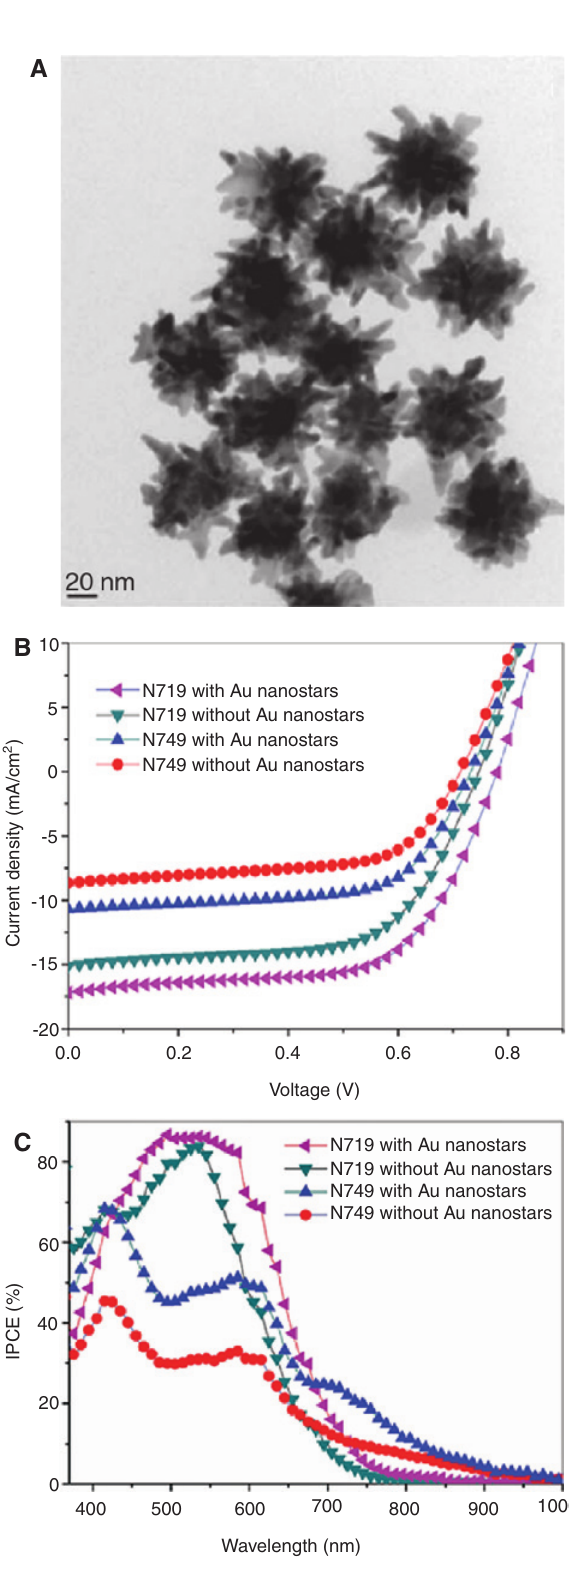
Figure 19: (A) Transmission electron microscopy (TEM) image of Au nanostars, (B) J – V characteristics of N719 and N749 DSSCs with and without Au nanostars, (C) IPCE action spectra for N719 and N749 DSSC devices with and without Au nanostars. Reproduced from [103] with permission of The Royal Society of